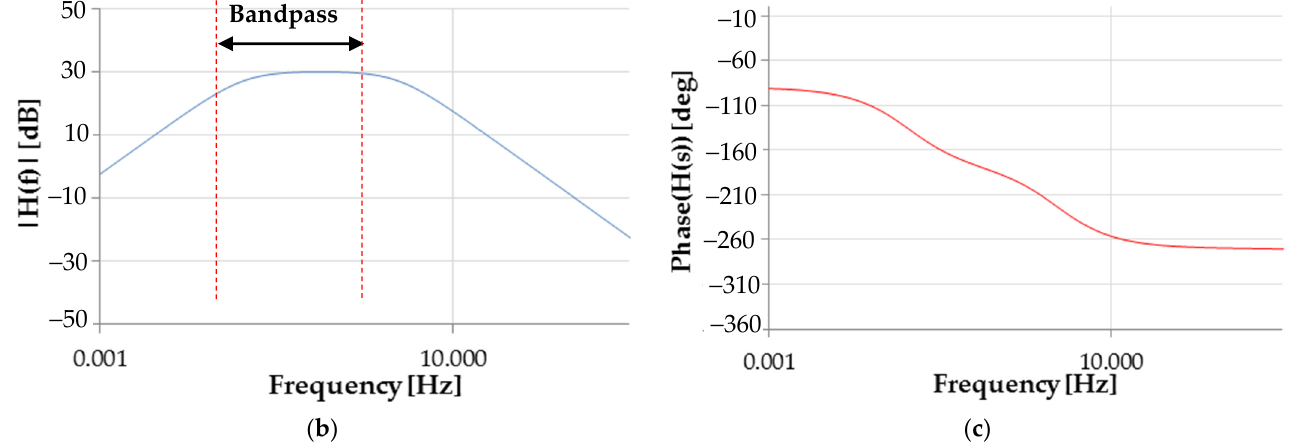
Figure 2. Circuit scheme of the electronic conditioning section ( a ). Bode plot of the realized active filter: magnitude ( b ) and phase ( c ).